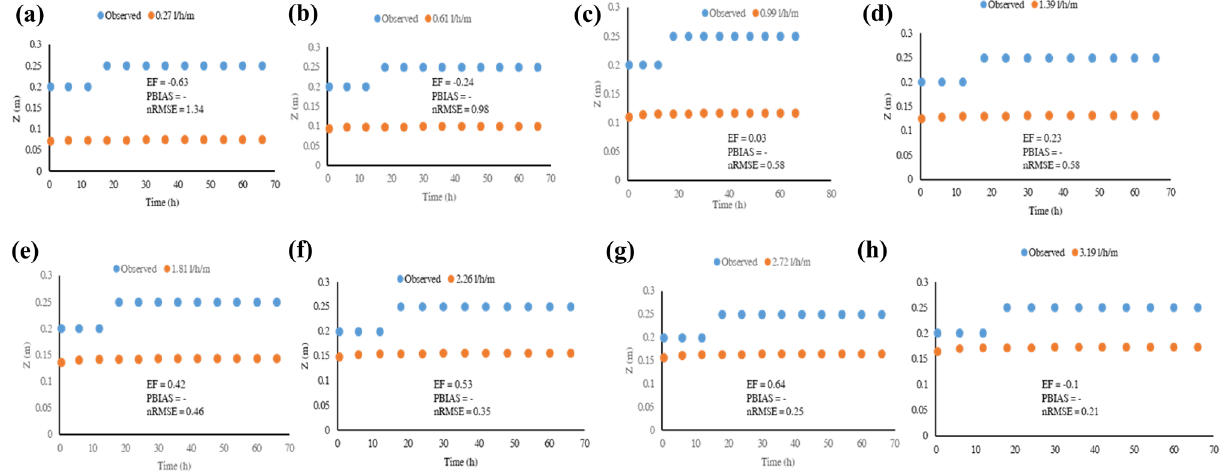
Figure 8. Observed vs Simulated wetted depths for silty clay loam at operating head of: ( a ) 20 kPa, ( b ) 40 kPa, ( c ) 60 kPa, ( d ) 80 kPa, ( e ) 100 kPa, ( f ) 120 kPa, ( g ) 140 kPa, and ( h ) 160 kPa. Wetted width Wetted